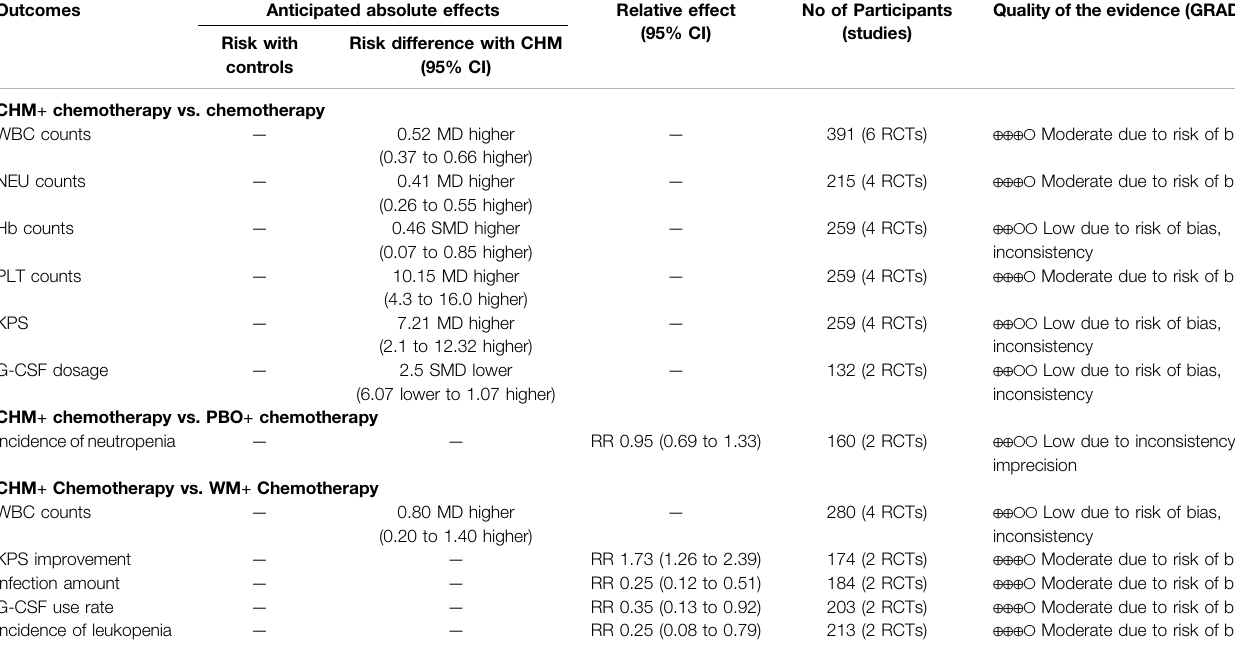
TABLE 4 | Assessment of evidence